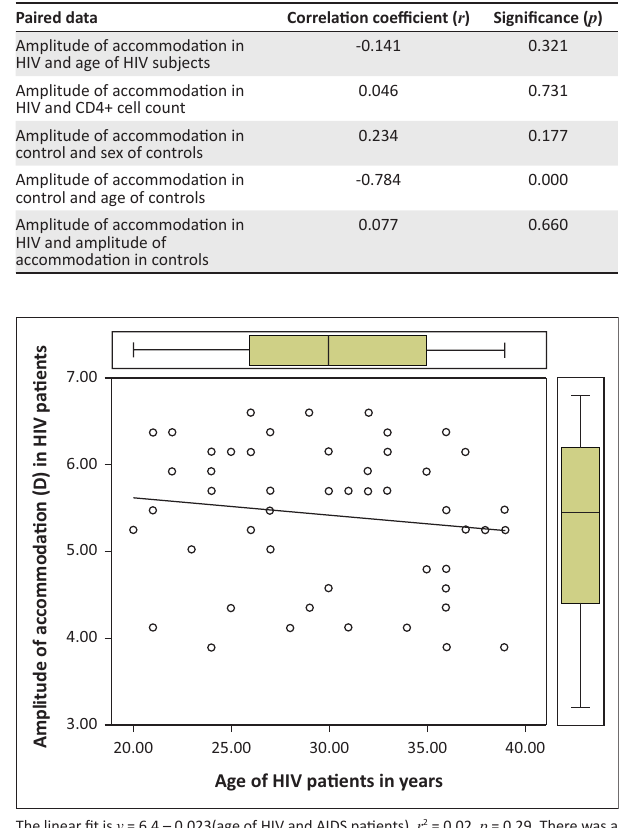
FIGURE 1: Box plots for the subjective amplitudes of accommodation in HIV and AIDS patients and the control group. Each box plot represents the distribution of the measurements concerned.